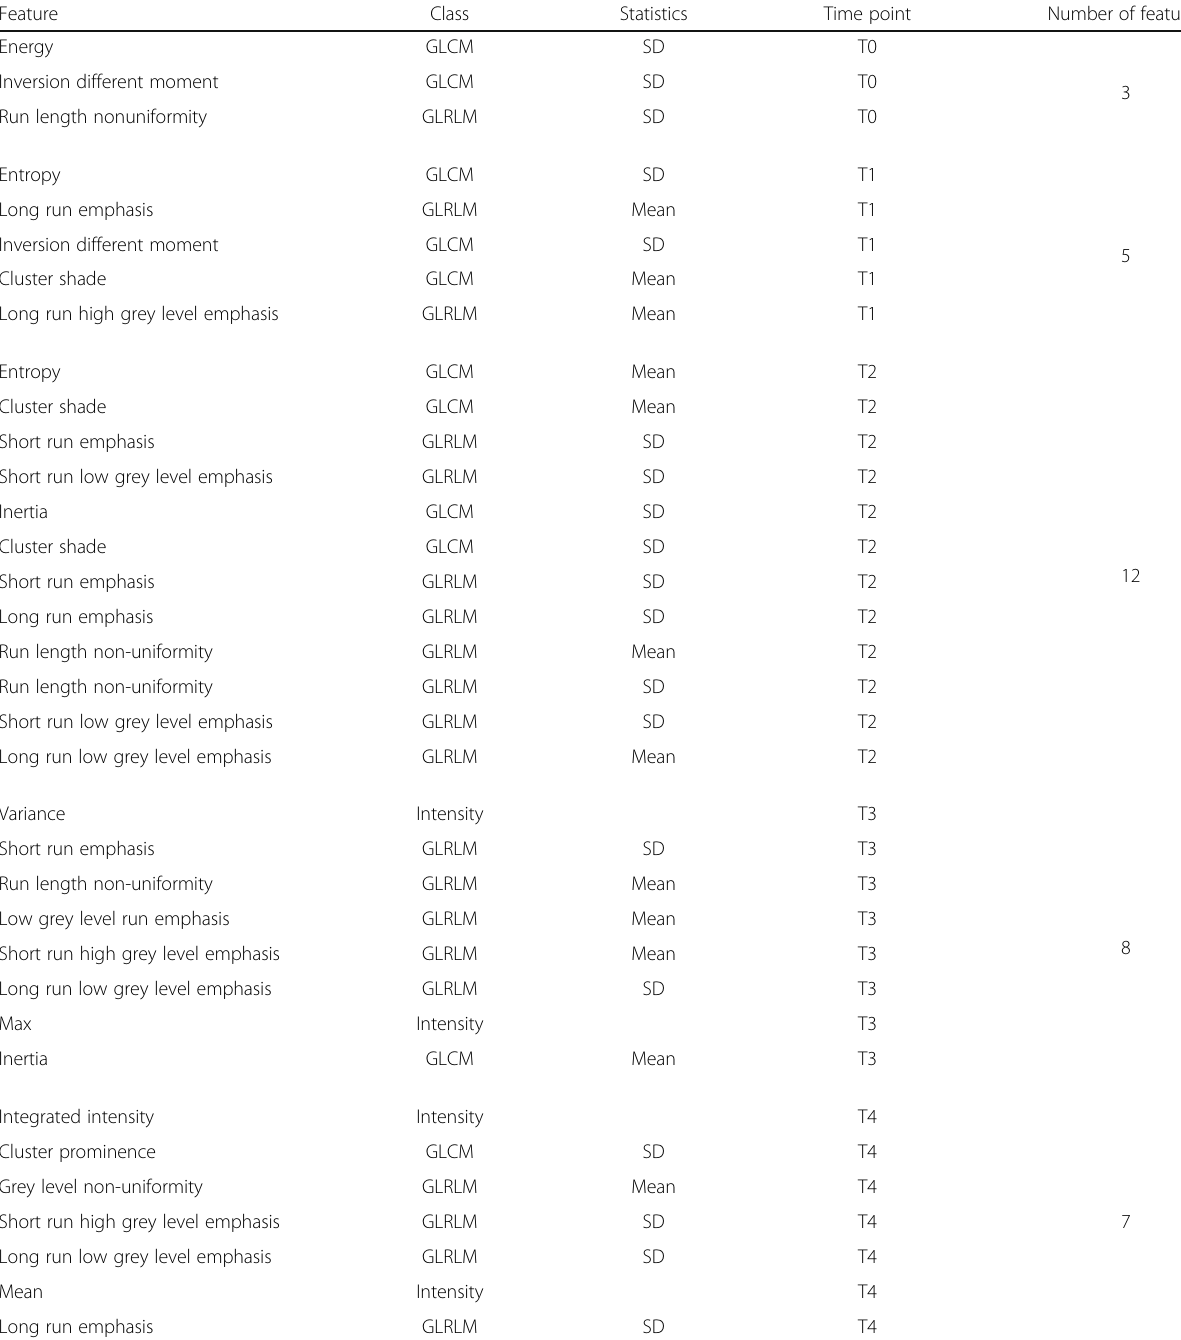
Table 3 Features extracted using the TWIST (training with input selection and testing) algorithm